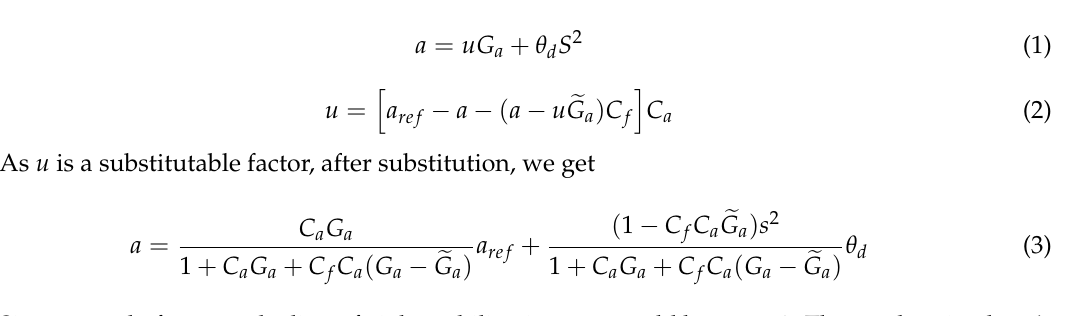
 Figure 1. The EDOB method. G a is the acceleration open-loop transfer function. (cid:101) G a is the approximate Figure 1. The EDOB method. is the G is the acceleration open-loop transfer function. a G a model of the platform. C a and C f is respectively the acceleration controller and the controller of C is respectively the acceleration controller and approximate model of the platform. C and f disturbance compensation. ACC respects the MEMS accelerometer. a ref , a is the given acceleration and a the output acceleration. θ d is the external the controller of disturbance compensation. ACC respects the MEMS accelerometer. ref a , a is θ is the external disturbance. the given acceleration and the output acceleration. d